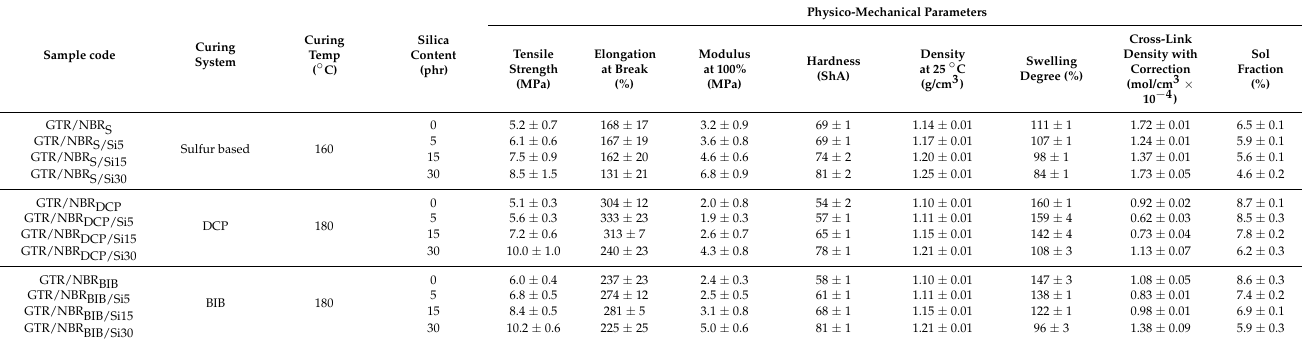
Table 4. Physico-mechanical parameters of GTR/NBR composites as function of curing system and silica content.